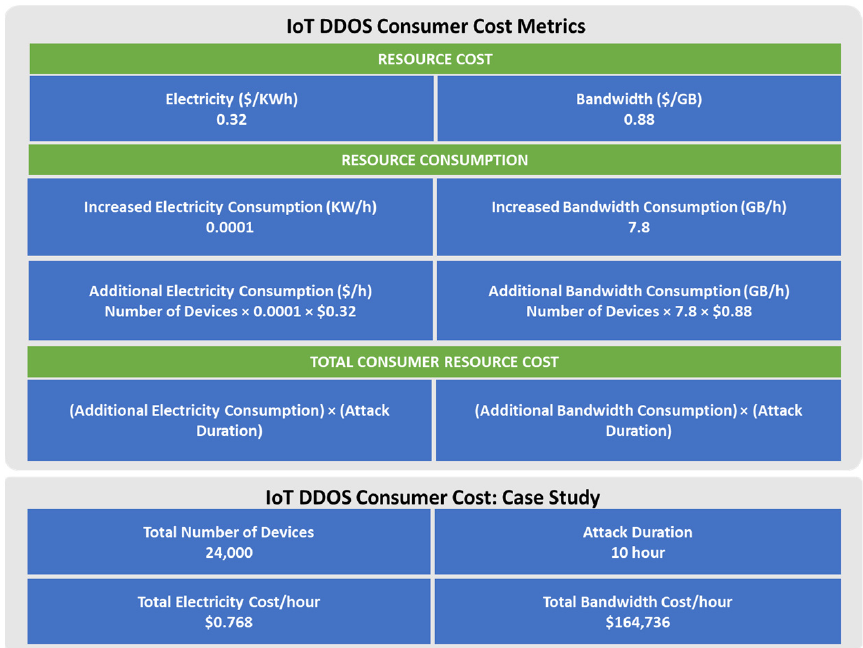
Figure 1. Quantifying the cost of insecure IoT devices.